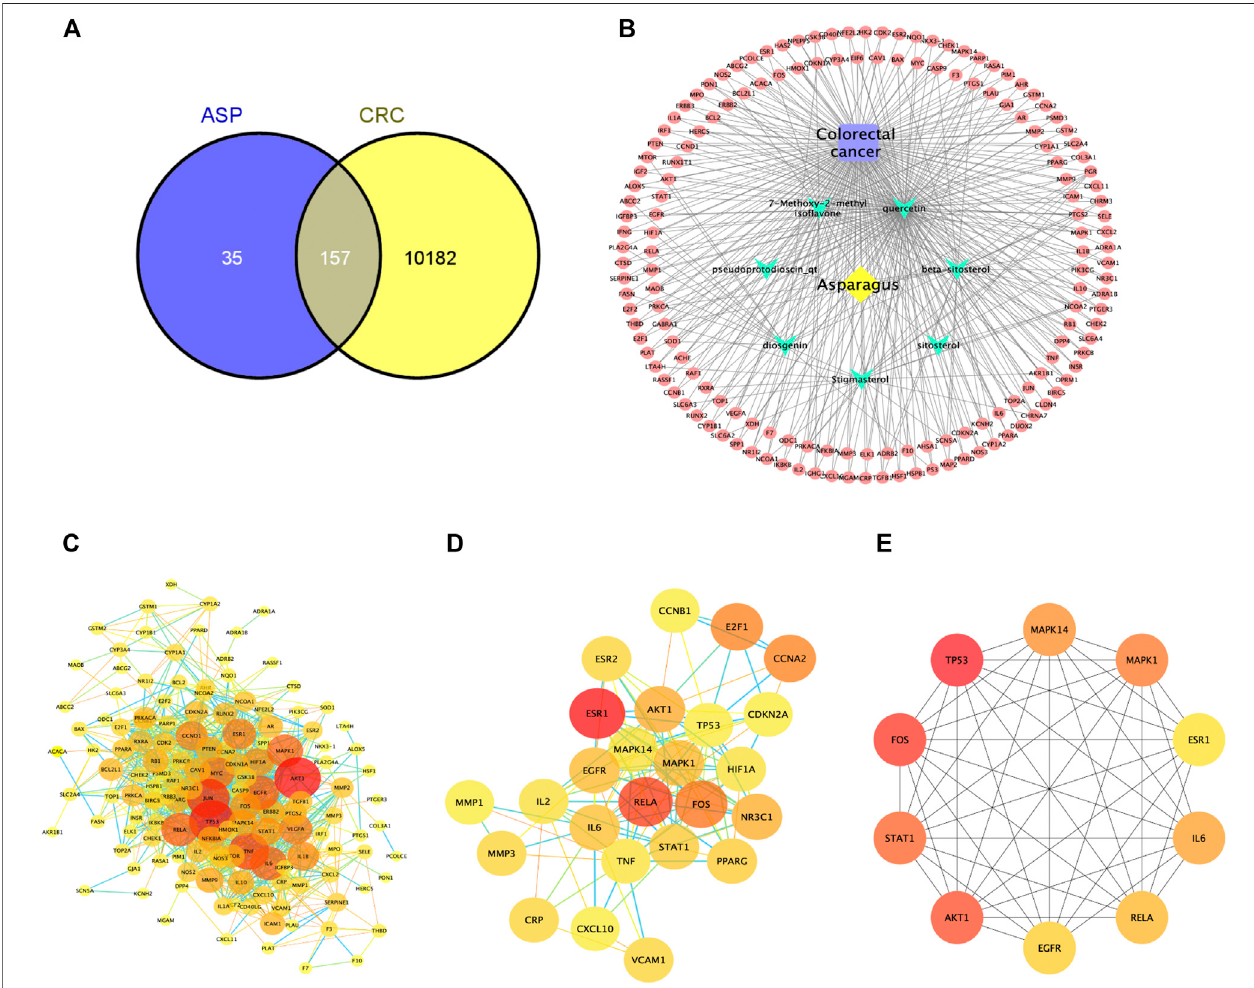
FIGURE 2 | Network pharmacological analysis of asparagus (ASP). (A) Venn diagram showing the 157 common targets of ASP in colorectal cancer (CRC). (B) Compound-disease-target network of ASP against CRC. (C) Protein-protein interactions identi fi ed by STRING software (visualized by Cytoscape 3.7.1 software). (D) Cluster subnetwork based on MCODE analysis with a score of 10.667. (E) Top 10 core nodes derived according to the MCC algorithm.